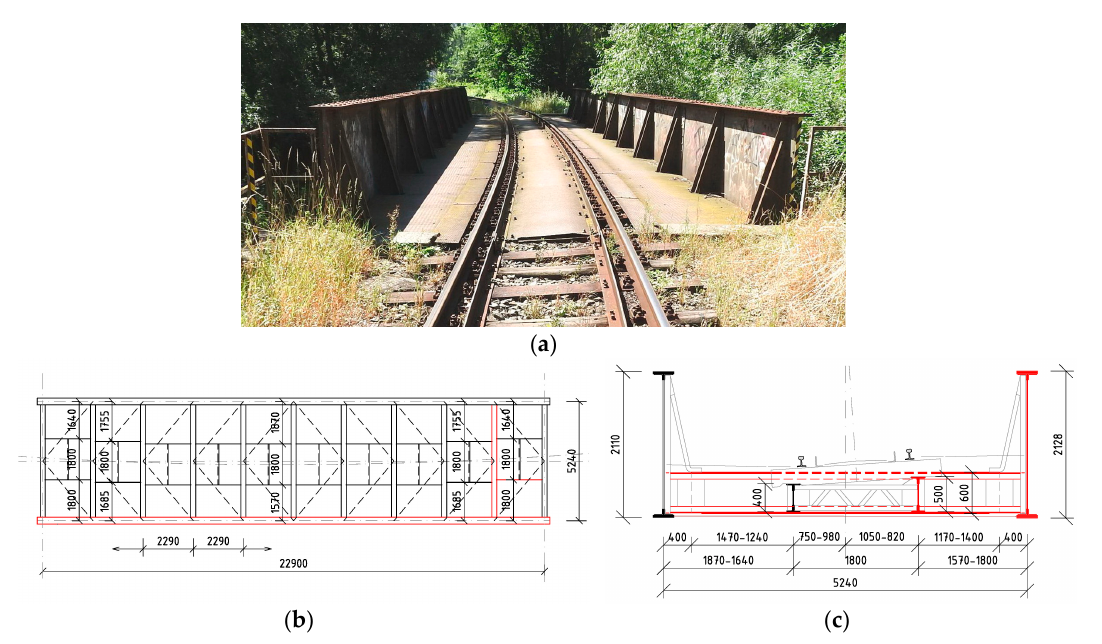
Figure 2. Bridge 2: the 109-year-old plate girder bridge with the bottom open member deck across a local stream: ( a ) picture of the bridge from the track; ( b ) schematic ground plan of the superstructure; ( c ) cross-section of the bridge; the chosen elements are drawn in red in ( b ) and ( c ).